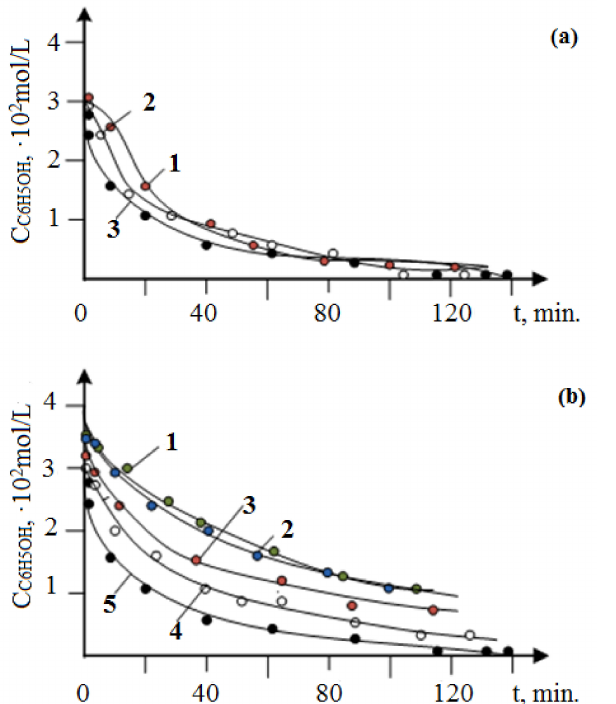
Figure 15. Dependence of phenol concentration on oxidation time: ( a ) in the presence of 1, Fe 3 O 4 ; 2, CoFe 2 O 4 ; 3, CoFe 2 O 4 /PEI; ( b ) in the presence of CoFe 2 O 4 /PEI: 1, 30 ◦ C; 2, 40 ◦ C; 3, 50 ◦ C; 4, 60 ◦ C; 5, 80 ◦ C.